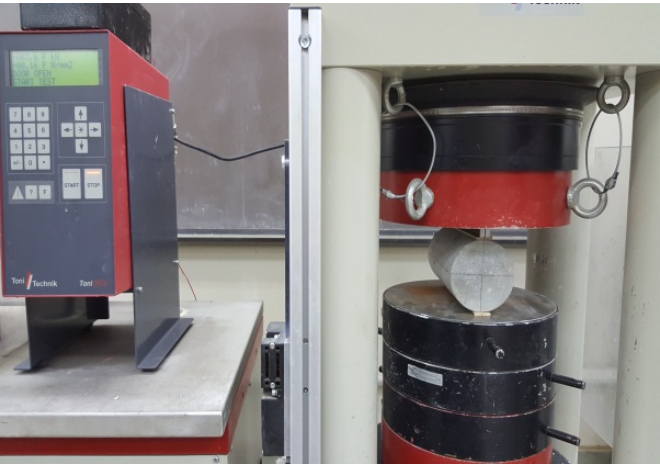
Figure 13. Test setup for splitting tensile strength test.